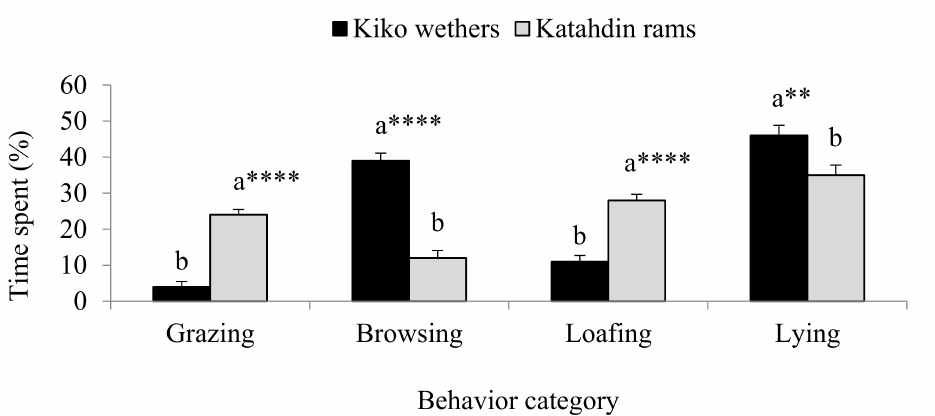
Figure 6. Diurnal (dawn–dusk) time (LS means ± SE) spent by Kiko wethers and Katahdin rams in woodlands, June–August 2018 ( a,b LS means with different letters within each behavior category differ; ** p < 0.01, **** p <